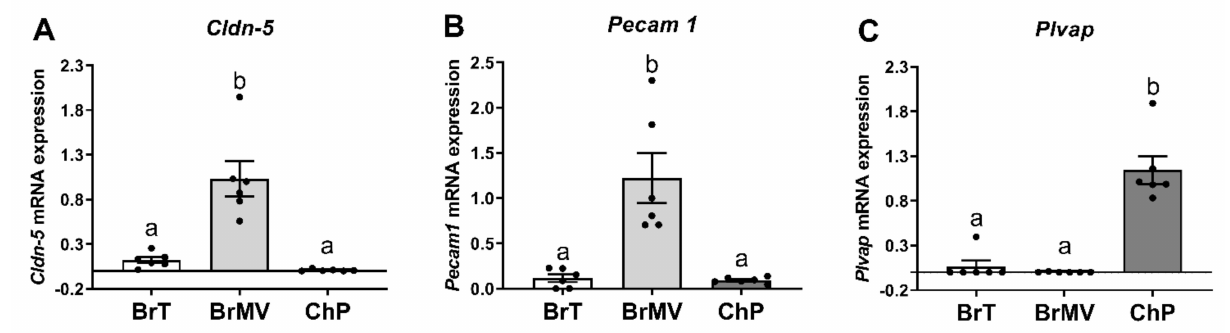
Figure 2. Mean ( ± SEM) relative mRNA expression of claudin-5 ( Cldn-5, A ), endothelial cell adhesion molecule ( Pecam1 , B ), and plasmalemma vesicle-associated protein ( Plvap , C ) in brain tissue (BrT, white bars), brain microvessels (BrMV, grey bars), and choroid plexus (ChP, dark bars) isolated from rats brain ( n = 6, 6 females/3 samples and 6 males/3 samples for each time point). Different lowercase letters indicate significant differences at p <